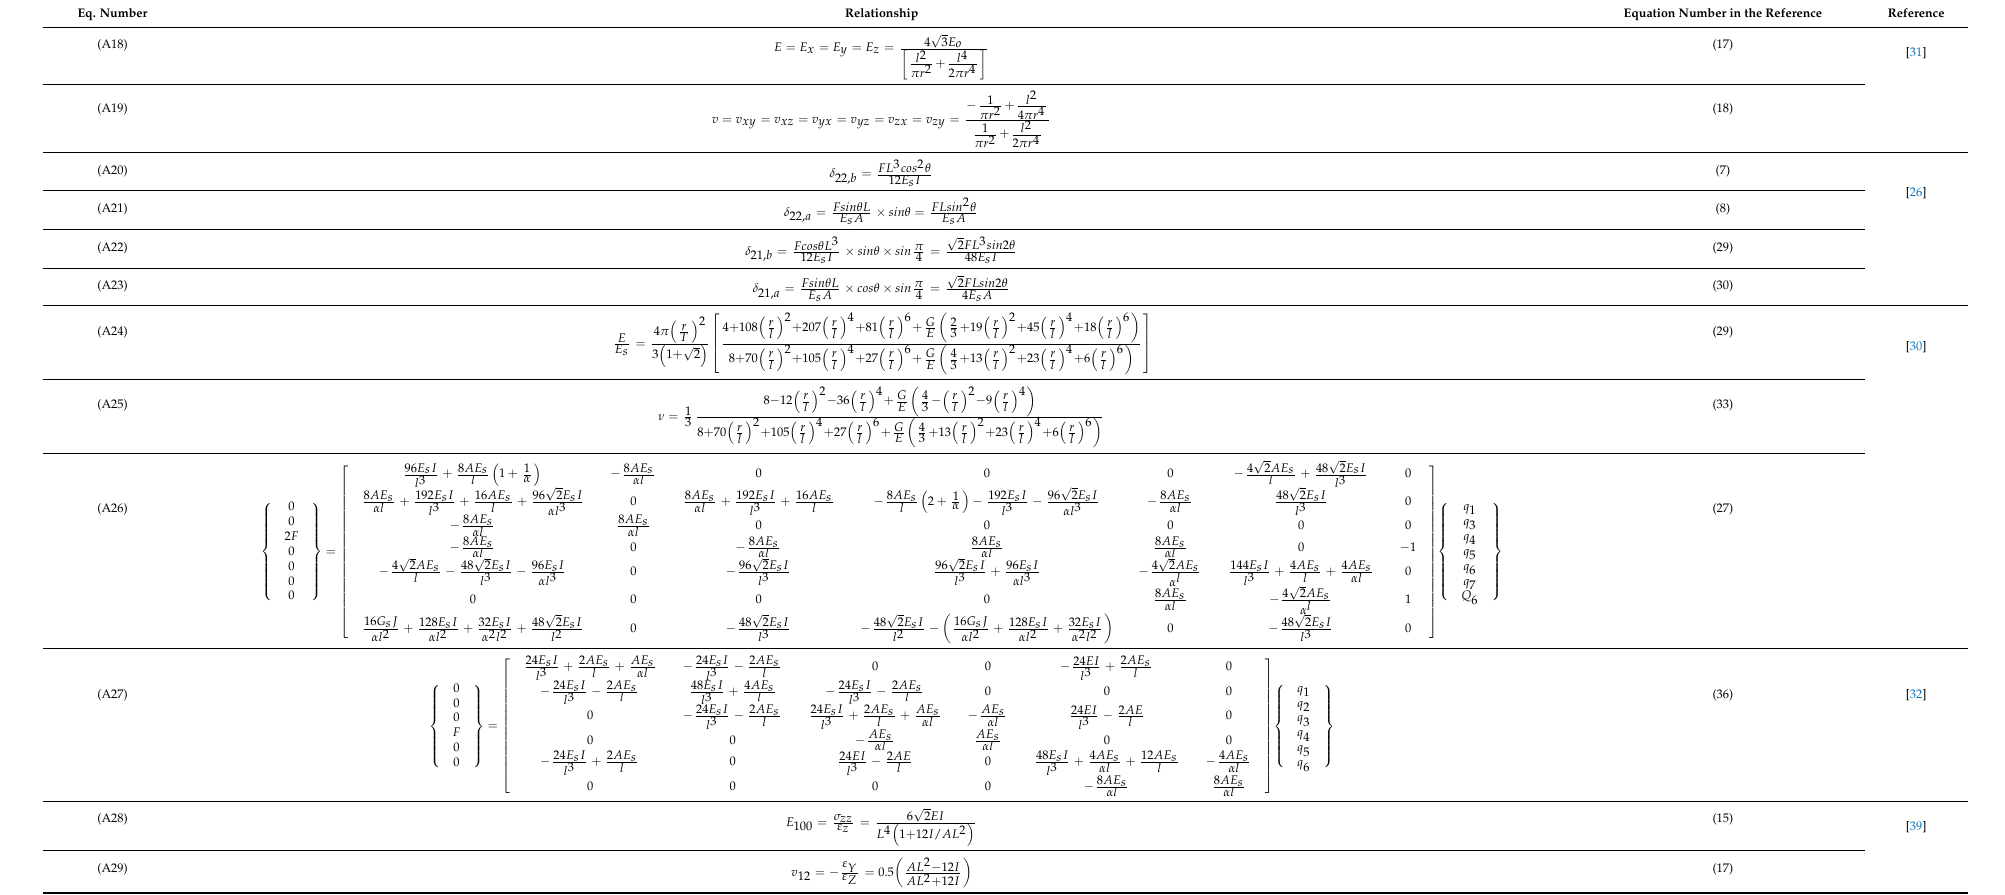
Table A1. The list of equations extracted from the literature and used in this